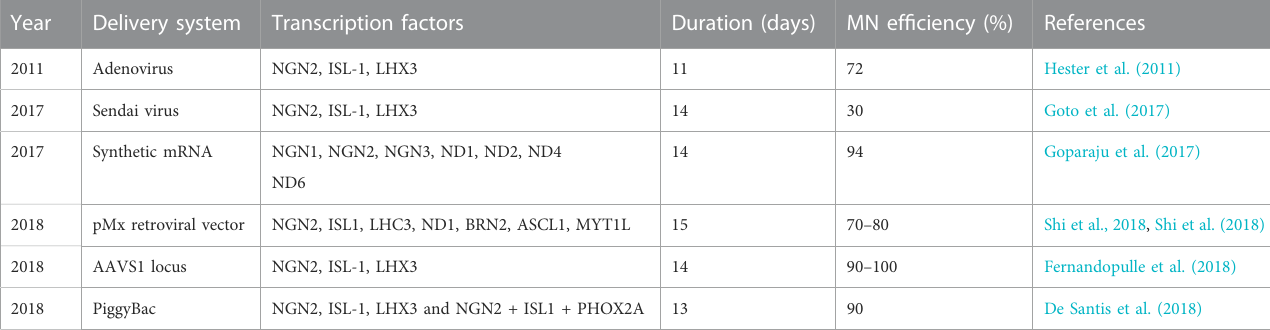
TABLE 2 Protocols using transcription factor expression to direct the differentiation of human iPSCs into